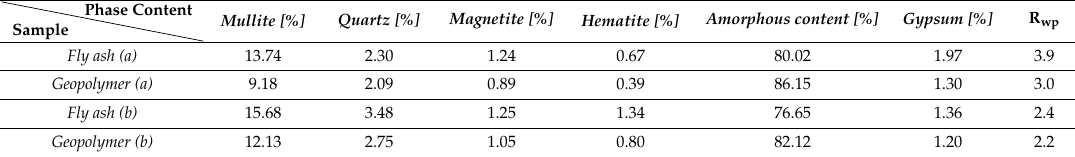
Table 4. Composition quantified using TOPAS (v.5 Bruker) for a sample of fly ash and a sample of geopolymer from batch 2 of Table 3. The values for fly ash (a) and geopolymer (a) have been determined from a sample rotating at 30 rpm and using a knife edge collimator. The values for fly ash (b) and geopolymer (b) have been determined from a sample which was not rotating and a knife edge collimator was not used. R wp is the weighted profile R